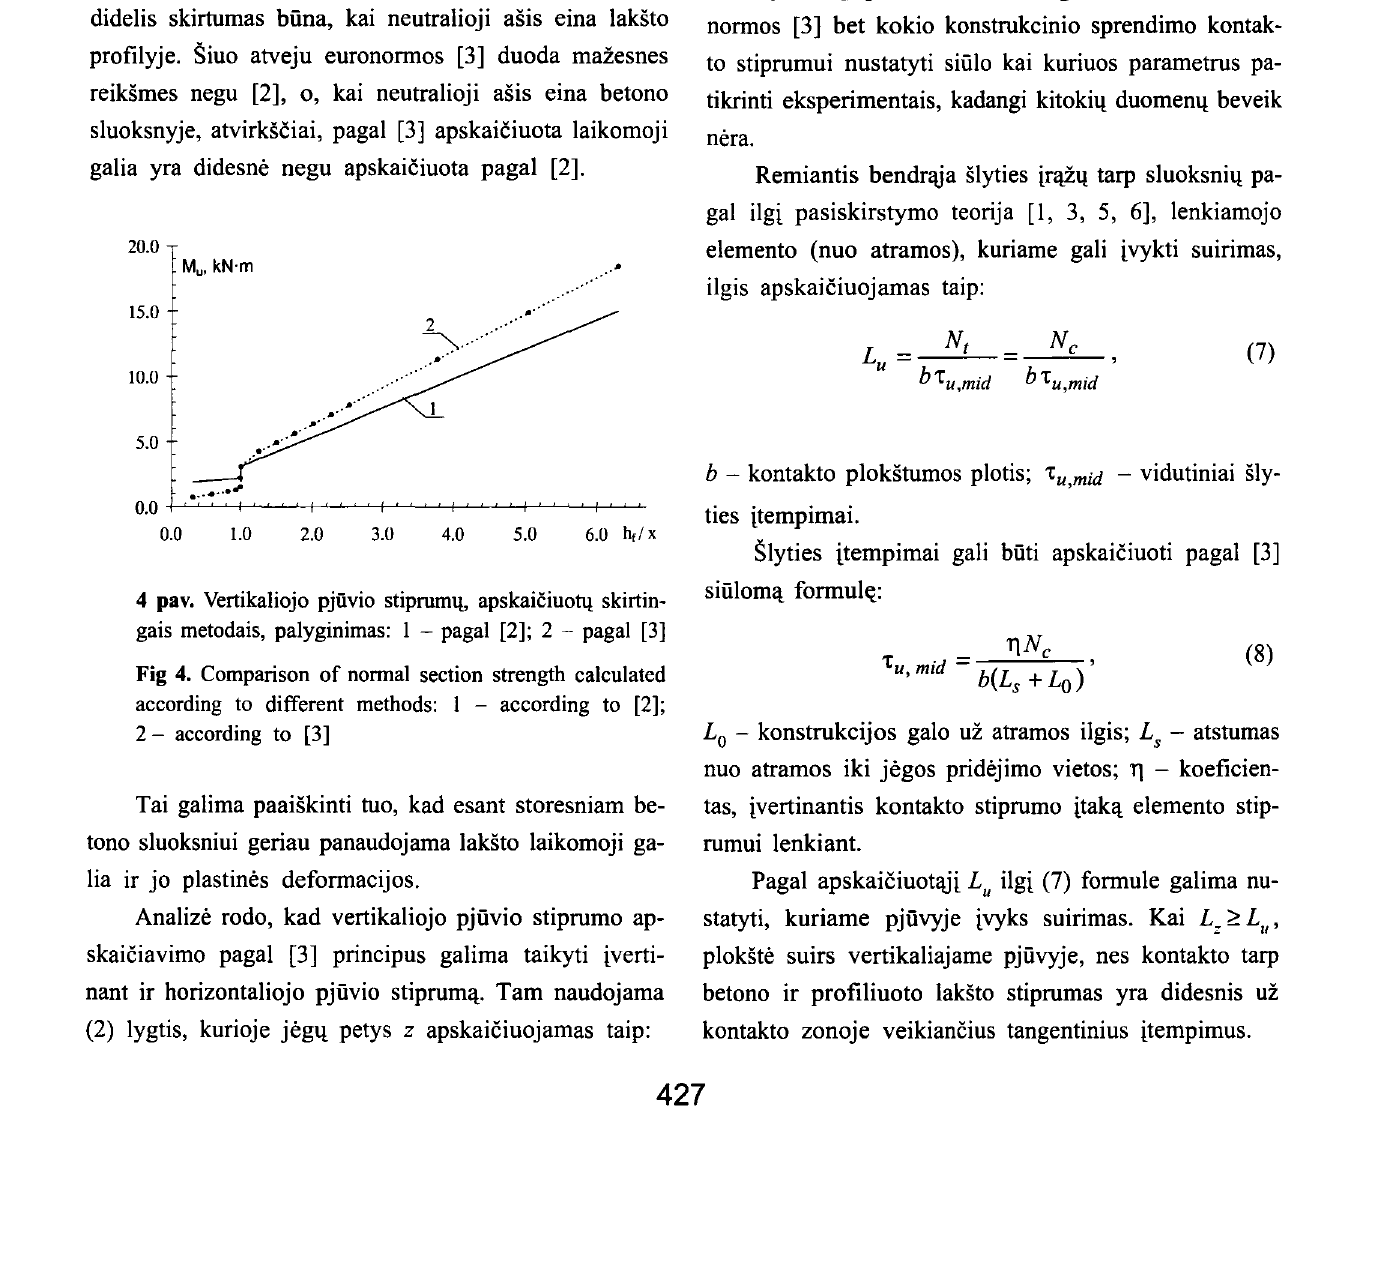
tas, ivertinantis kontakto stiprumo itak~ elemento stip rumui